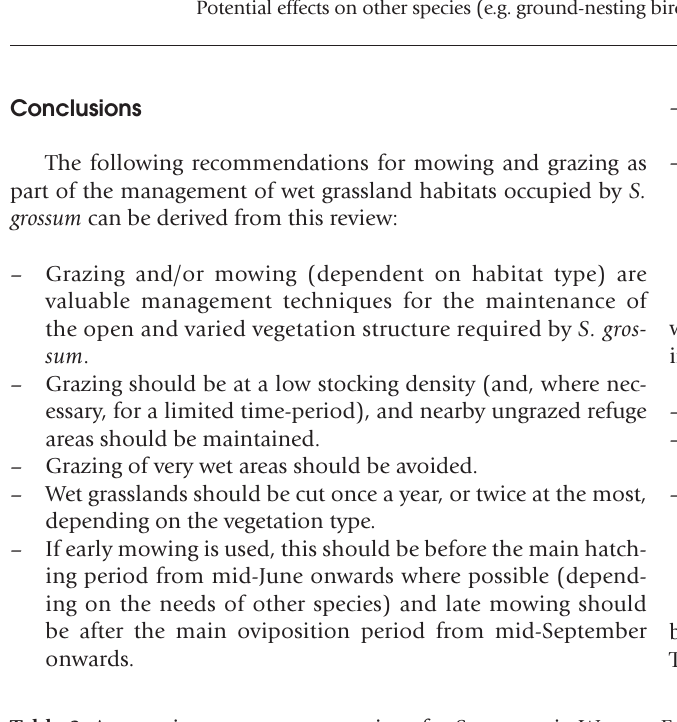
Table 3. Appropriate management options for S. grossum in Western Europe.